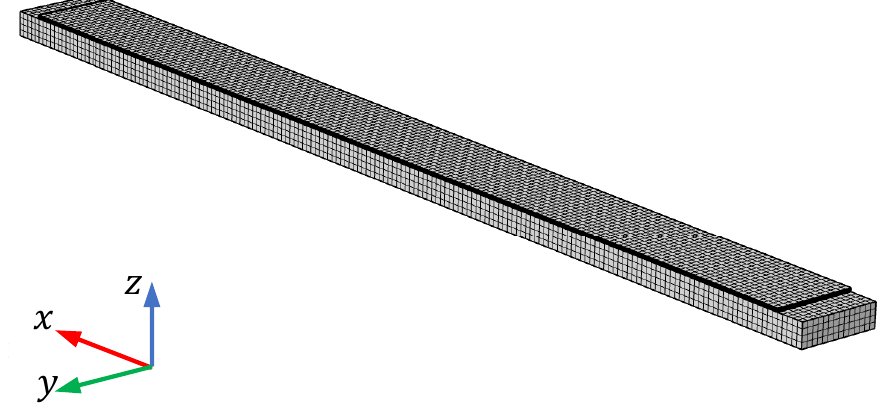
Figure 13. Mapped mesh used to discretize the